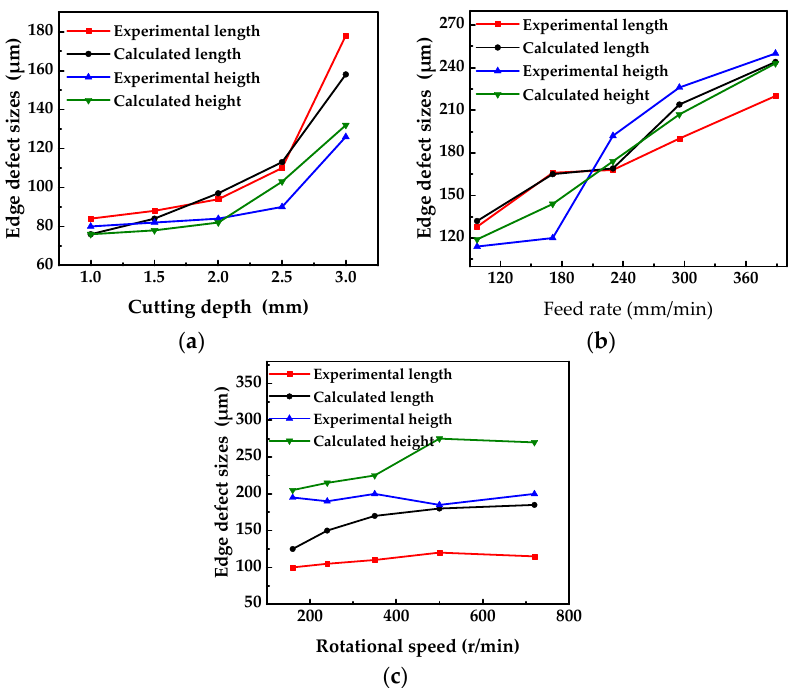
Figure 6. Influence of cutting parameters ( a ) depth of cut, ( b ) feed rate, and ( c ) spindle speed on edge defect sizes.